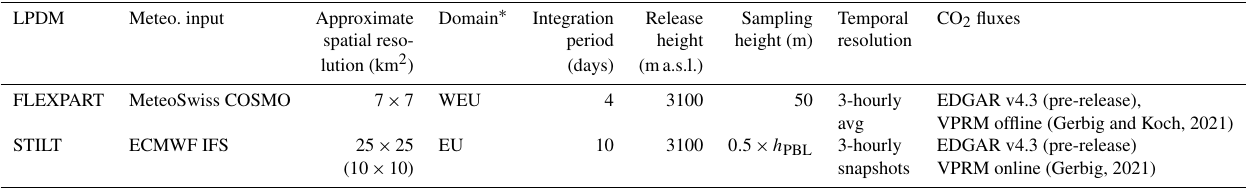
Table 1. Overview of atmospheric transport simulation models and their associated parameters. LPDM Meteo. input